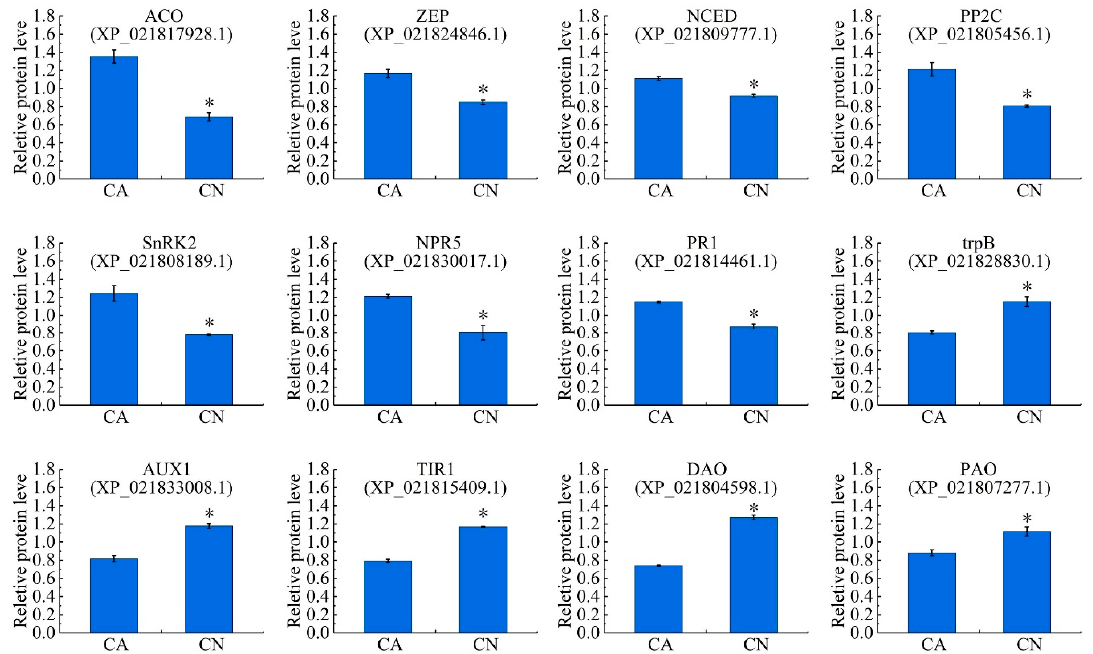
Figure 6. Relative expression levels of the proteins related to plant hormone and signal transduction. Significant differences in expression level were indicated by “*”.